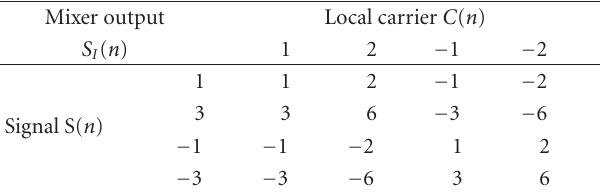
Table 2: Possible integer output values of the carrier mixer.